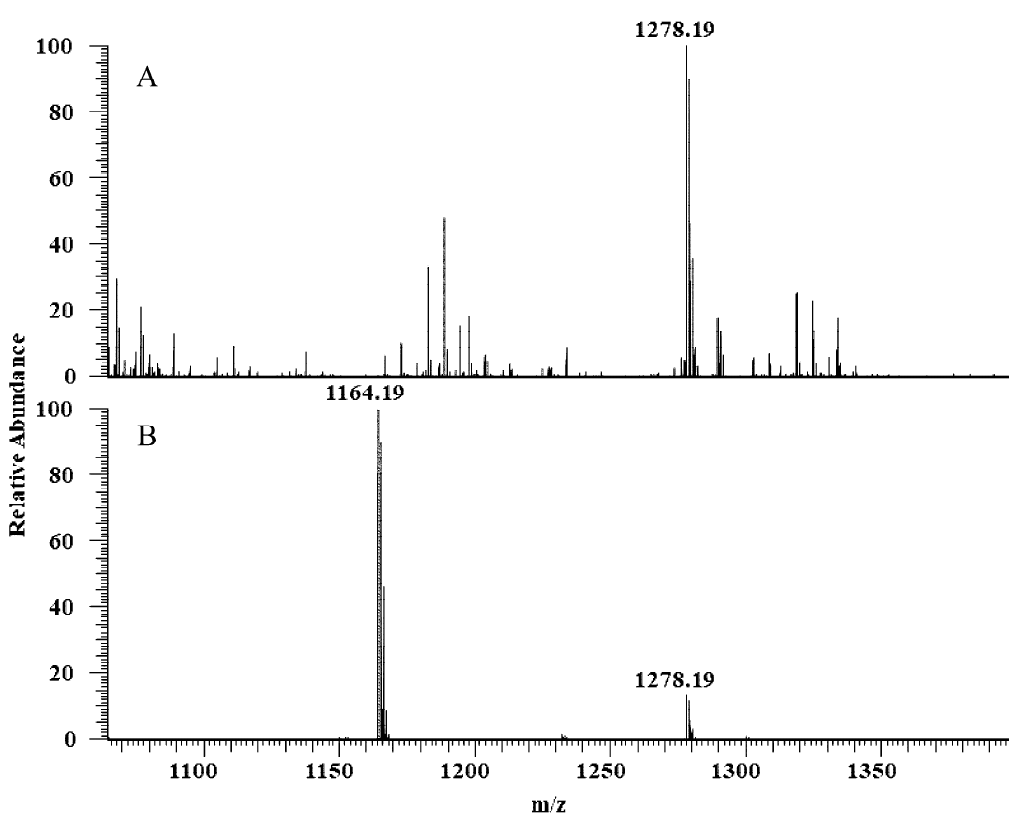
Figure 5. Full scan negative ions mass spectra of ( A ) mAGP treated with LysB-D29 with m / z 1278 corresponds to keto-mycolic acid, and ( B ) mycolic acid standard with m / z 1164 and 1278 corresponding to mycolic acid and keto-mycolic acid, respectively.